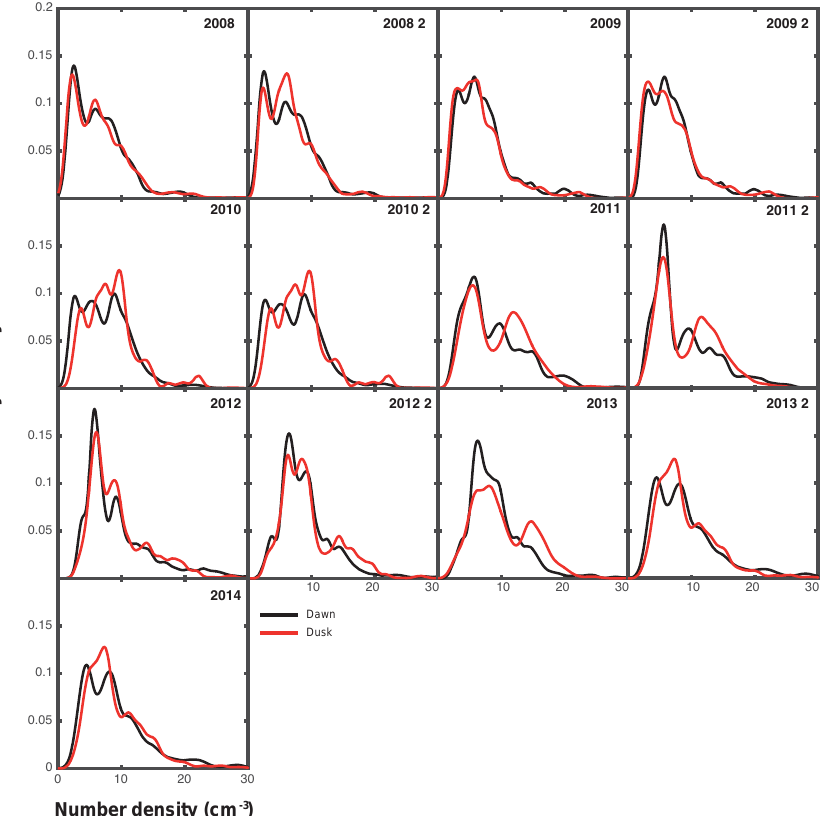
Figure B2. Yearly probability density functions of solar wind ion number density which correspond to magnetosheath data points on the dawn and dusk flanks. The “2” in each yearly label indicates that the data set spans the middle of that year to the middle of the next.